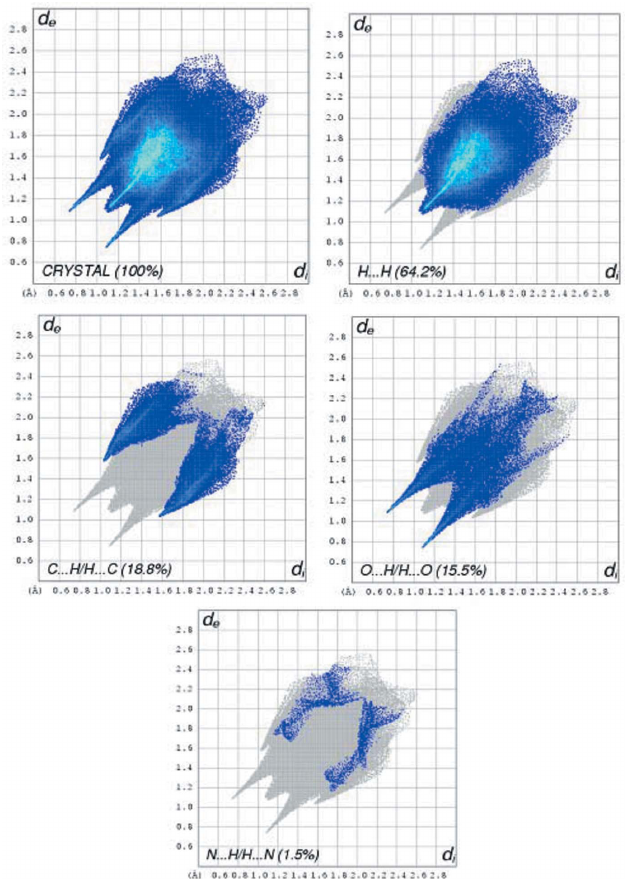
Figure 4 The total two-dimensional fingerprint plot of the crystal and of the relative contributions of the atom pairs to the Hirshfeld surface.